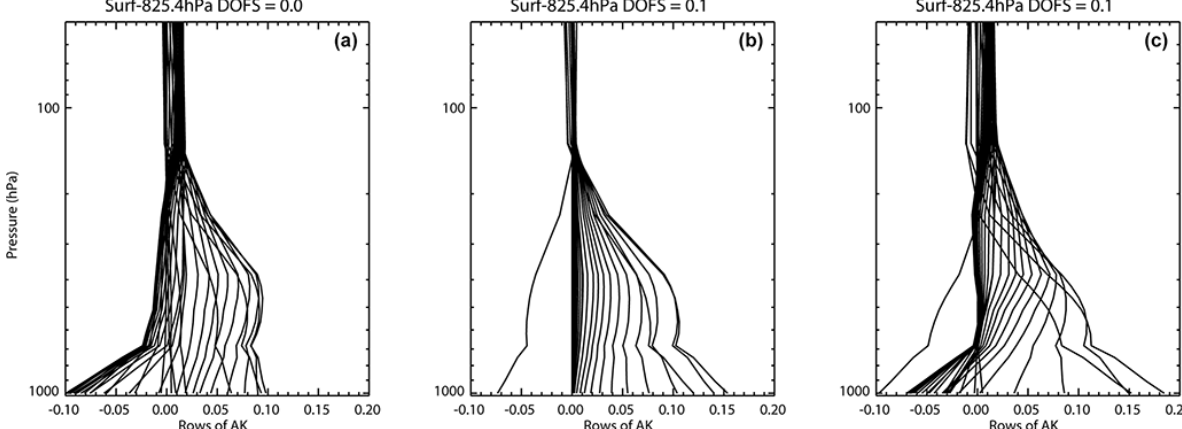
Figure 7. Plots of averaging kernel rows for CO 2 retrievals. The spectral ranges are (from a to c ) VLWIR + MWIR, SWIR, and VLWIR + MWIR + SWIR. These results are for the West Virginia